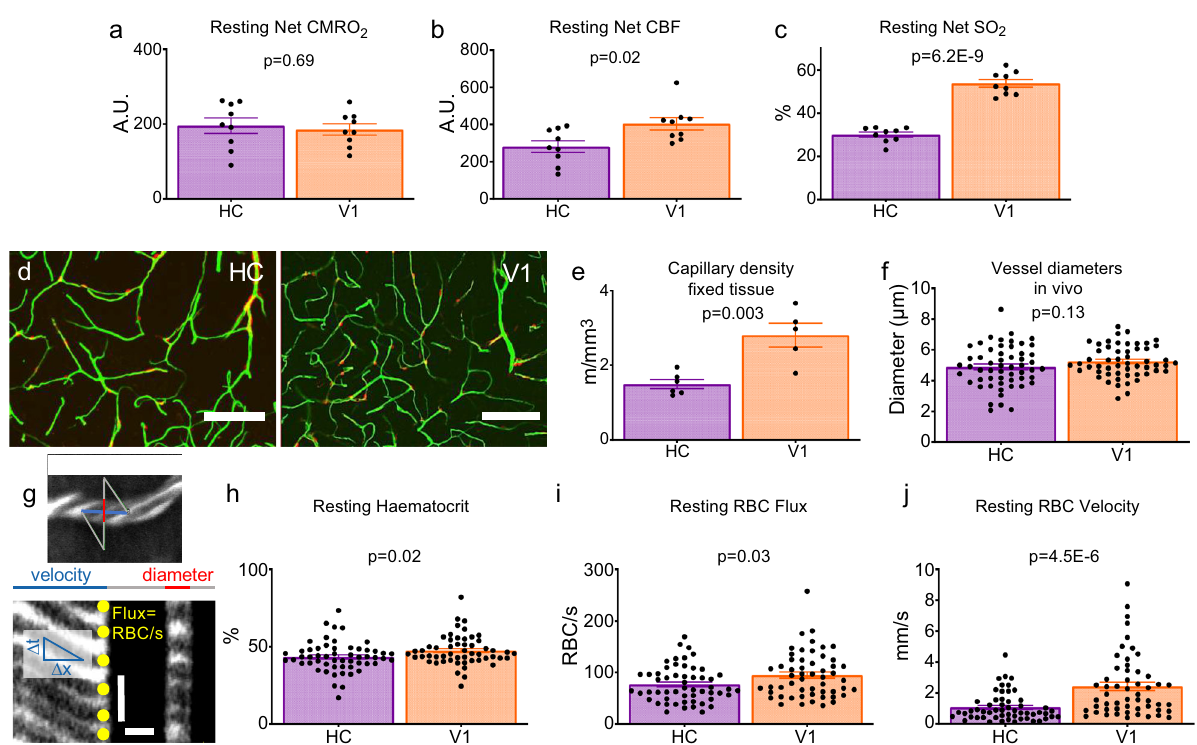
Fig. 2 Baseline haemodynamics in HC and V1. Estimated CMRO 2 a , CBF b and oxygen saturation (SO 2 ) c in HC (purple) and V1 (orange) in stationary mice in the dark (HC: 9 animals across 21 sessions; V1: 9 animals across 19 sessions, 1 – 5 sessions per mouse; data points are averages for each animal). d FITC-gelatin fi lled vessels (green) from the HC and neocortex of one NG2-DsRed mouse (pericytes are red). Scale bars represent 100 μ m. Example images are projections of the 200 μ m Z-stacks compared in e . e Capillary density in these slices was signi fi cantly lower in HC ( N = 6 slices, fi ve mice) compared with V1 ( N = 5 slices, four mice). f Single capillaries were imaged in vivo using two-photon microscopy (HC: 55 vessels from 11 mice, V1: 54 vessels from 14 mice), and the average diameter of the vessels scanned did not differ between HC (mean: 4.9 µ m) and V1 (mean: 5.2 µ m, t test p = 0.13). g Example line scan trajectory from one in vivo two-photon recording to represent the 99 vessels scanned in f (top; as input into the acquisition software — the actual trajectory will differ from that shown owing to mirror inertia). The scan path of the laser goes along (blue) and across (red) the capillary (labelled with i.v. Texas Red dextran, white. Dark stripes are RBCs). Each row in the corresponding line scan image (bottom) represents a single time point. As RBCs move, their shadow shifts along the vessel, so the angle of the stripes (left, under blue line) shows how fast they are moving. The vessel diameter can be measured from the intensity pro fi le of the Texas Red-labelled lumen (right, under red line). The number of red blood cells per second can be calculated by counting the number of dark stripes (marked with yellow circles) within this time period. The vertical scale bar represents 5 ms, and the horizontal scale bar 5 μ m. Despite the same vessel types being scanned in f , the average resting h haematocrit, i RBC fl ux and j RBC velocity were different between regions (statistical comparisons were made on individual vessels, N speci fi ed in f ). Data in bar charts represent mean ± SEM, dots are individual vessels or mice, as indicated. P values are from independent sample t tests, or Mann – Whitney U tests (see Statistics Report Table SR1). Source data are provided as a Source Data fi